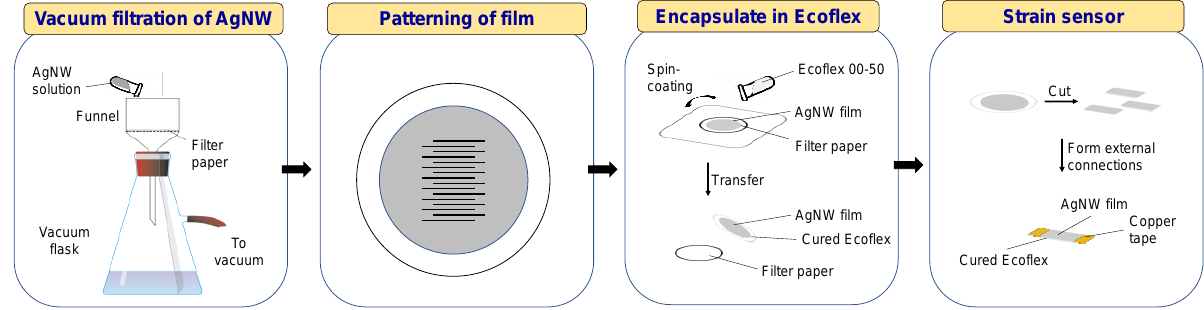
Figure 1. Fabrication processes of the kirigami-structured strain sensor with AgNWs. With regards to the network structure of AgNWs, the kirigami patterning was done on the AgNW film before spin-coating Eco-Flex on the network. This patterning also significantly decreases the hysteresis of the strain sensor, showing this architecture improved the conductive network of the AgNWs.